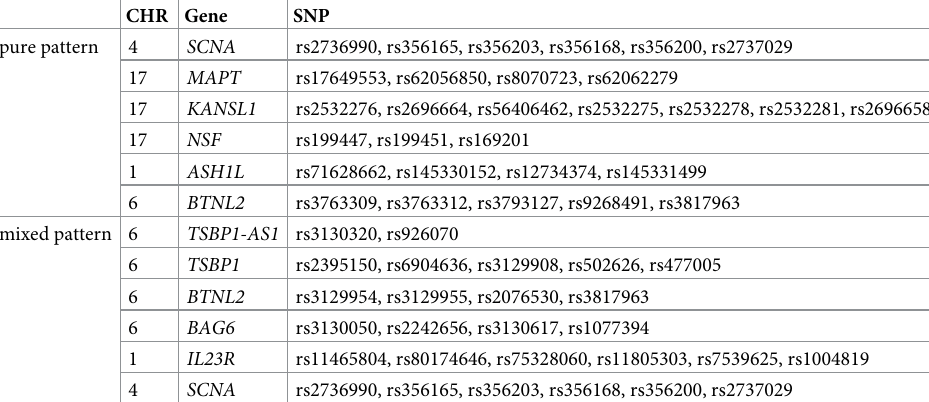
Table 4. Some key variants identified in